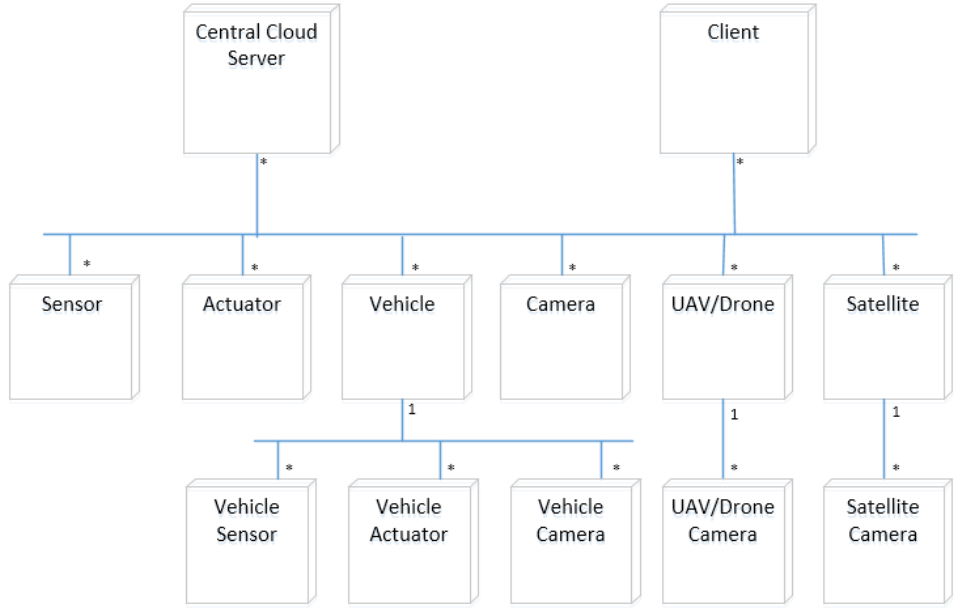
Figure 6. Reference Deployment View for IoT-Based Smart City Inf. Man. Systems (1 and * stands for one-to-many relation).